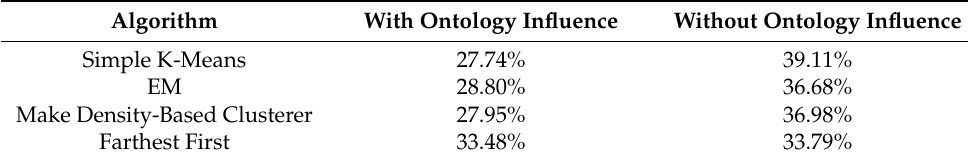
Table 1. Percentage of incorrectly clustered instances on the Real Reviews dataset.